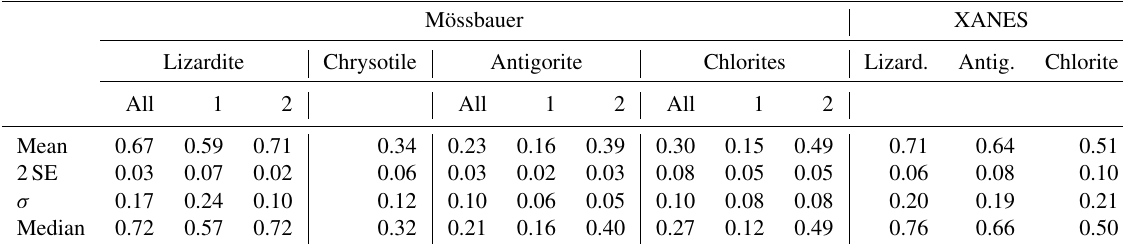
Table 3. Statistical parameters of Fe 3 + / Fe total ratios in serpentine and low-Fe chlorite mineral